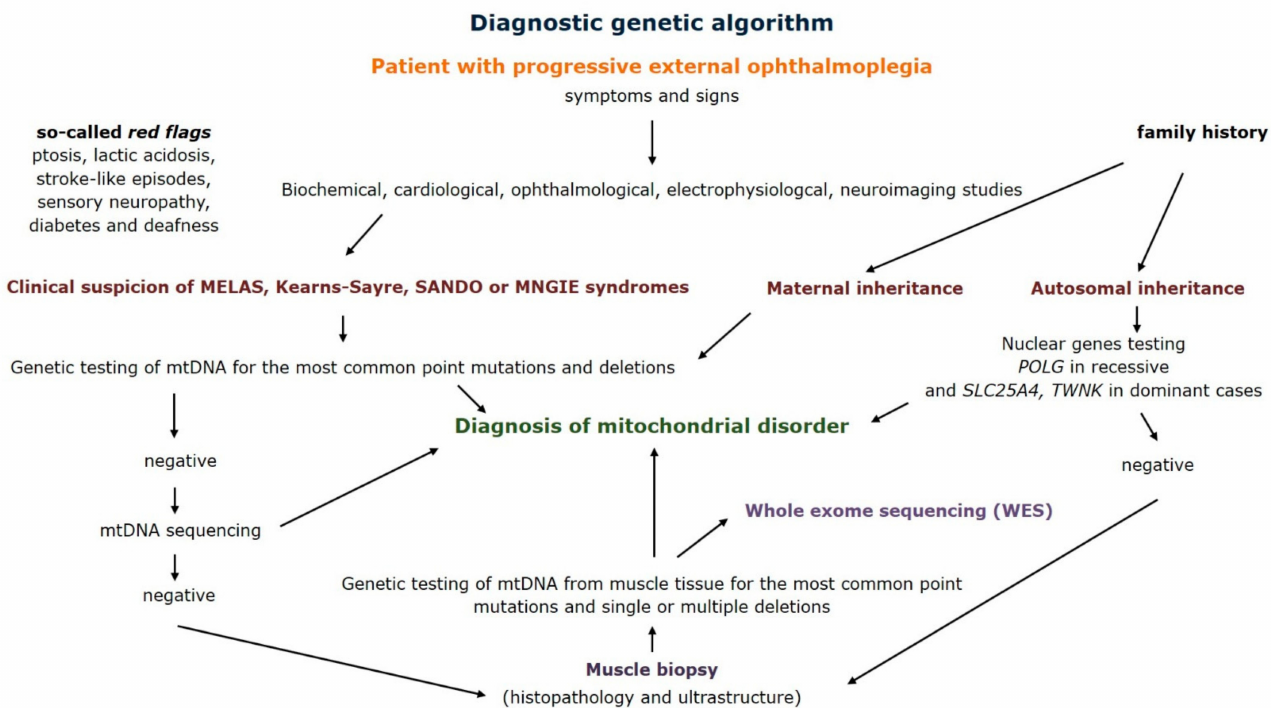
Figure 6. Diagnostic genetic algorithm for patients with progressive external ophthalmoplegia (MELAS—mitochondrial encephalomyopathy, lactic acidosis and stroke-like episodes syndrome, SANDO—sensory ataxic neuropathy, dysarthria, ophthalmoparesis syndrome, MNGIE—mitochondrial neurogastrointestinal encephalomyopathy